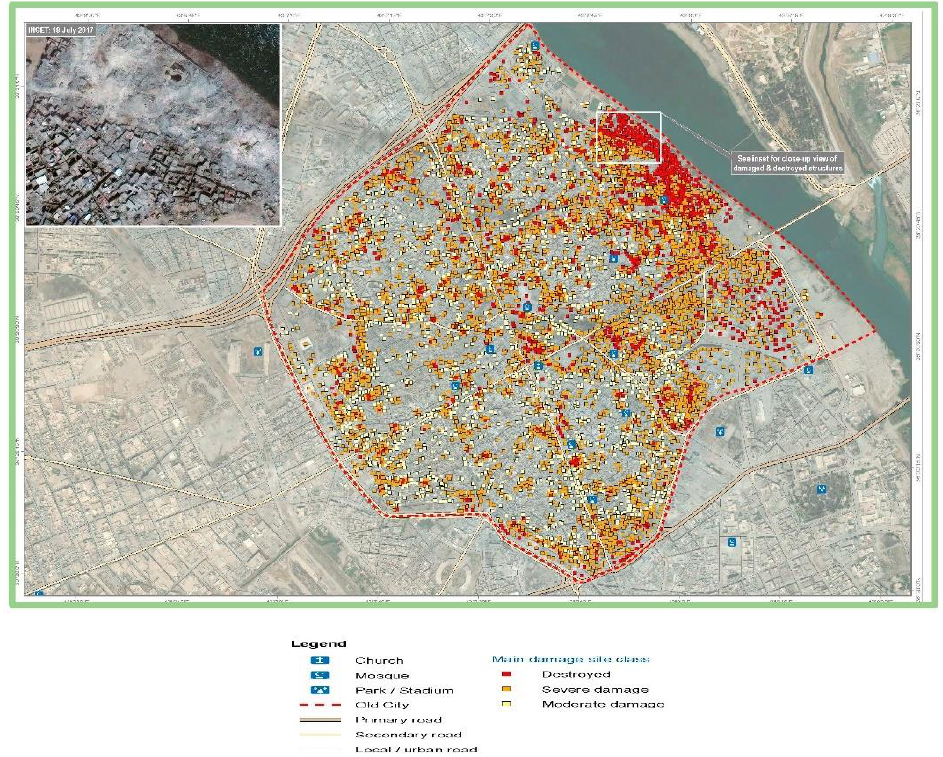
Figure 8. Assessment of the damages to the urban fabric of the study area after the war (Source: UNIOSAT, 21 July 2017 reproduced with permeation from [https://unitar.org/maps/map/2631] [26].